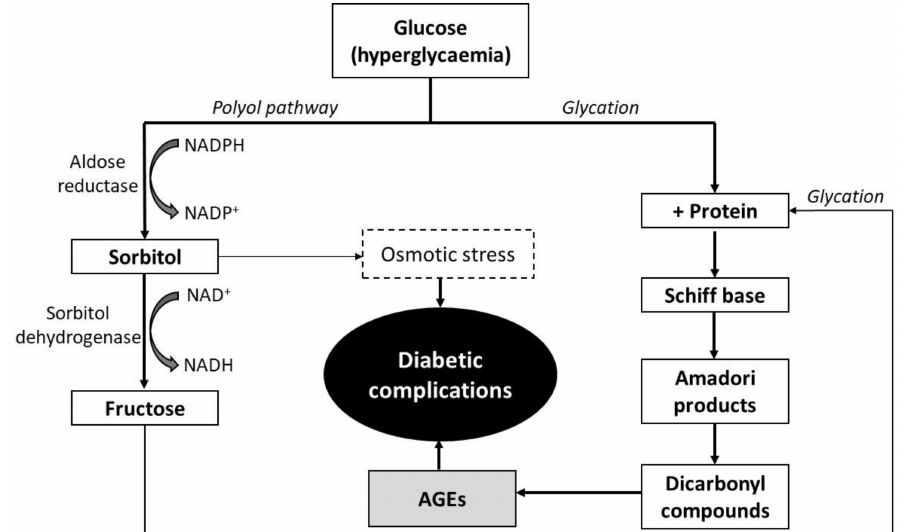
Figure 2. Direct link between the polyol rout and non-enzymatic protein glycation pathways leading to advanced glycation end-products (AGEs) formation. In hyperglycaemia conditions, excessive glucose is sequentially reduced to sorbitol and fructose by the combined action of human aldose reductase and sorbitol dehydrogenase. Accumulation of sorbitol in tissues is implicated in the development of degenerative complications of type-2 diabetes (neuropathy, nephropathy, retinopathy, etc.) due to osmotic stress. Fructose, the end-product of the polyol pathway, can be further conjugated with proteins increasing AGEs generation and related complications.